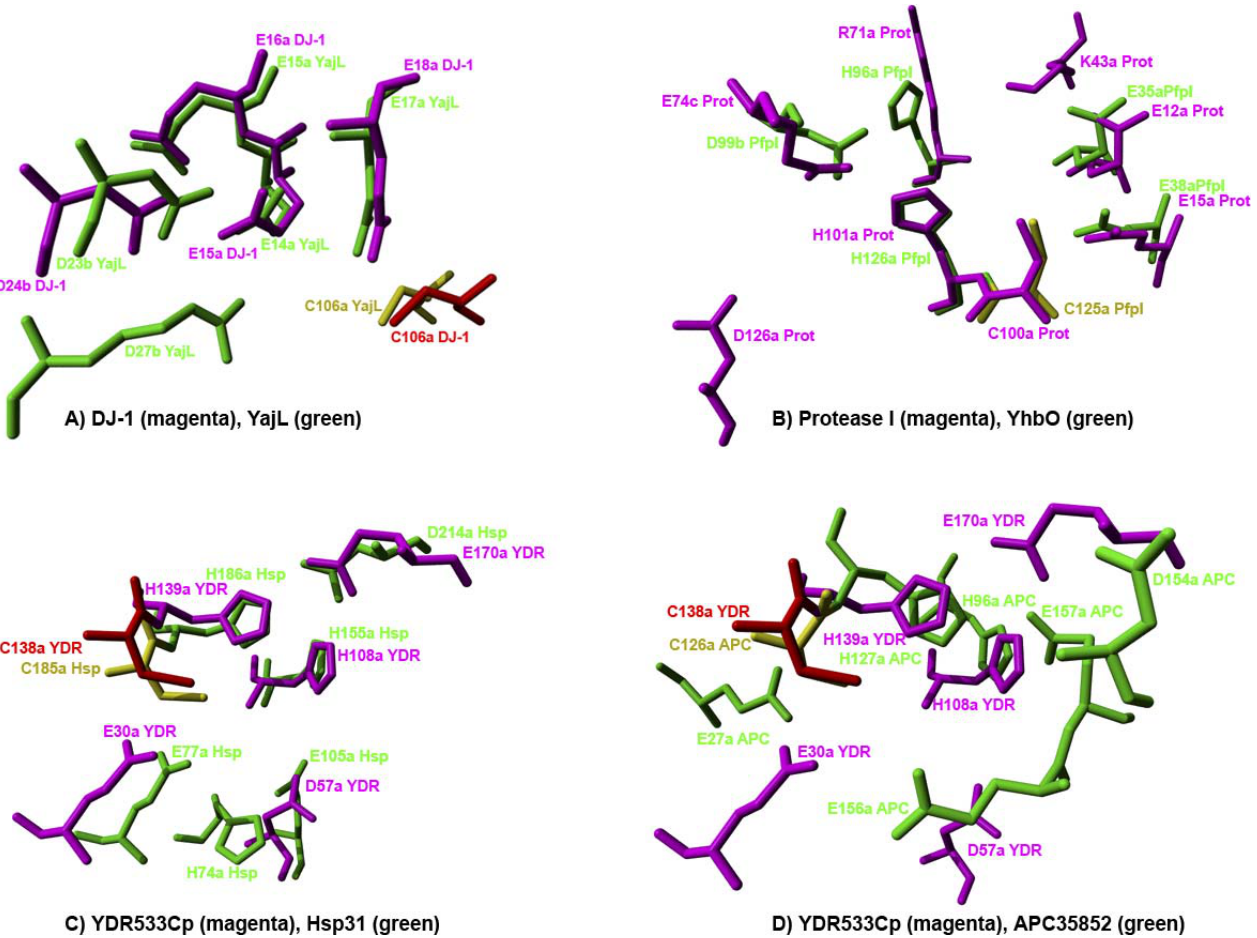
Figure 3. Superpositions of the THEMATICS Predicted Active Site Residues (in Green and Magenta) for DJ-1 Family Members (A) DJ-1 (magenta), YajL (green); (B) Protease I (magenta), YhbO (green); (C) Ydr533 (magenta), Hsp31 (green); (D) Ydr533 (magenta), APC35852 (green). The conserved cysteine residues that are not THEMATICS-positive residues are included for comparison purposes and are shown in yellow and